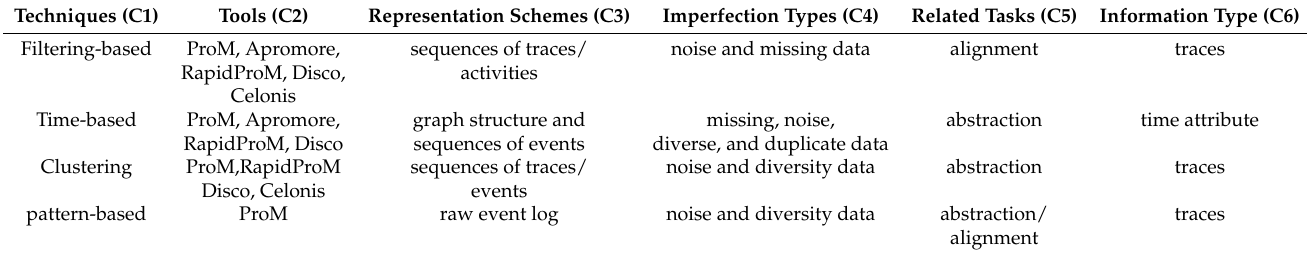
Table 6. Characteristics (C1–C6) on data preprocessing in the context of process